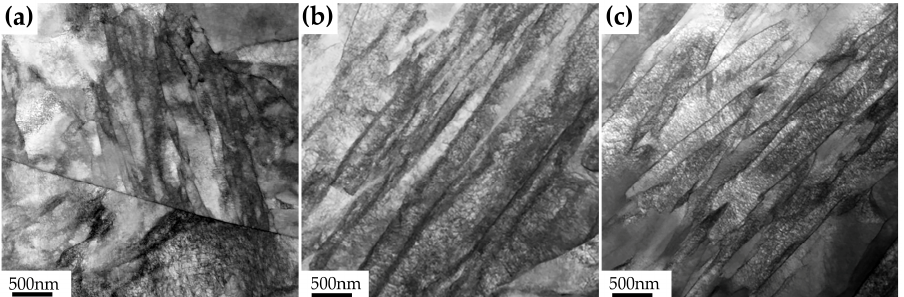
Figure 6. Bright field TEM images of the three steels with different Cu content tempered at 450 °C for 2 h: ( a ) 0Cu, ( b ) 1wt.% Cu, and ( c ) 3wt.% Cu.